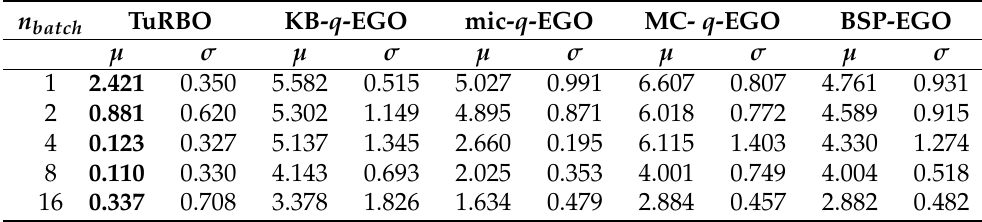
Table 5. Final results in terms of average ( µ ) and standard deviation ( σ ) over 10 execution of each algorithm for the Ackley benchmark function.